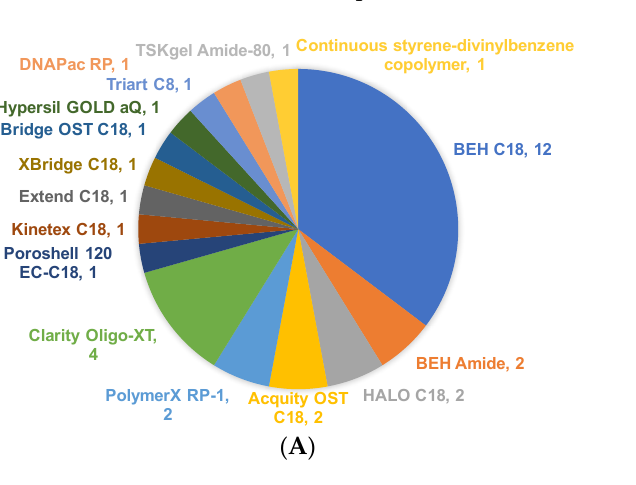
Figure 1. Different types of HPLC ( A ) and SPE ( B ) column sorbents used in the bioanalysis of OGNs. The number indicates the total applications of each sorbent. Data were summarized from a paper published from 2012 to August 2022. Detailed information is listed in Table 3.